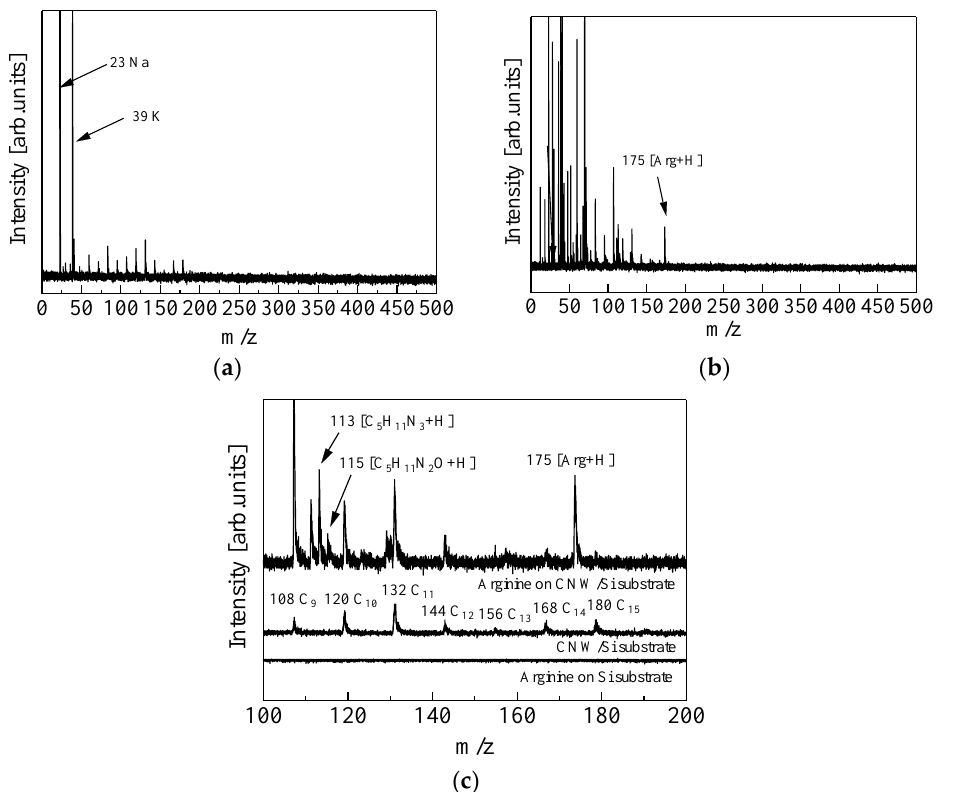
Figure 6. SALDI mass spectra. ( a ) CNW / Si substrate from 0 to 500 in m / z, ( b ) arginine on CNW / Si substrate from 0 to 500 in m / z, ( c ) enlargement from 100 to 200 in m / z, arginine on CNW / Si substrate, no sample on CNW / Si substrate, and arginine on Si substrate.